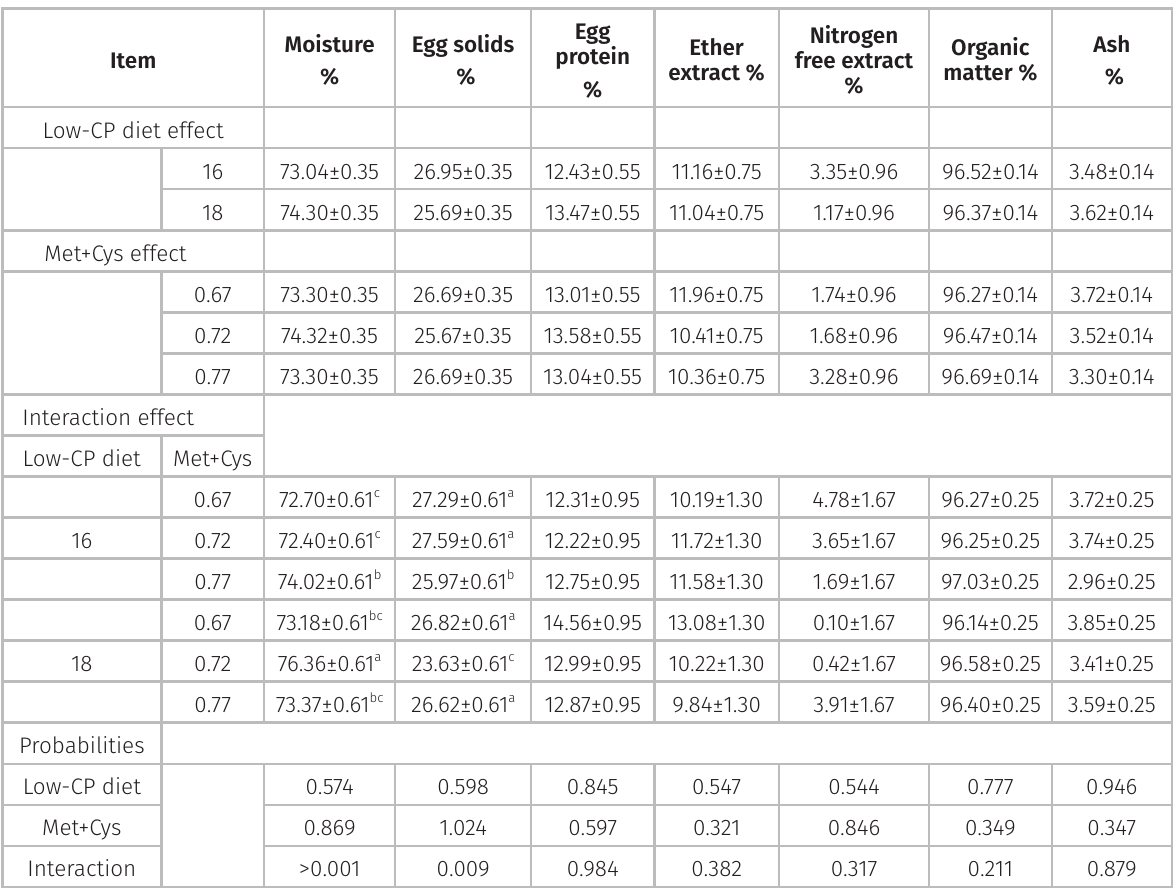
Table IV. Effect of low-protein diet with different levels of Met+Cys on chemical composition of whole egg of laying hens during the experimental